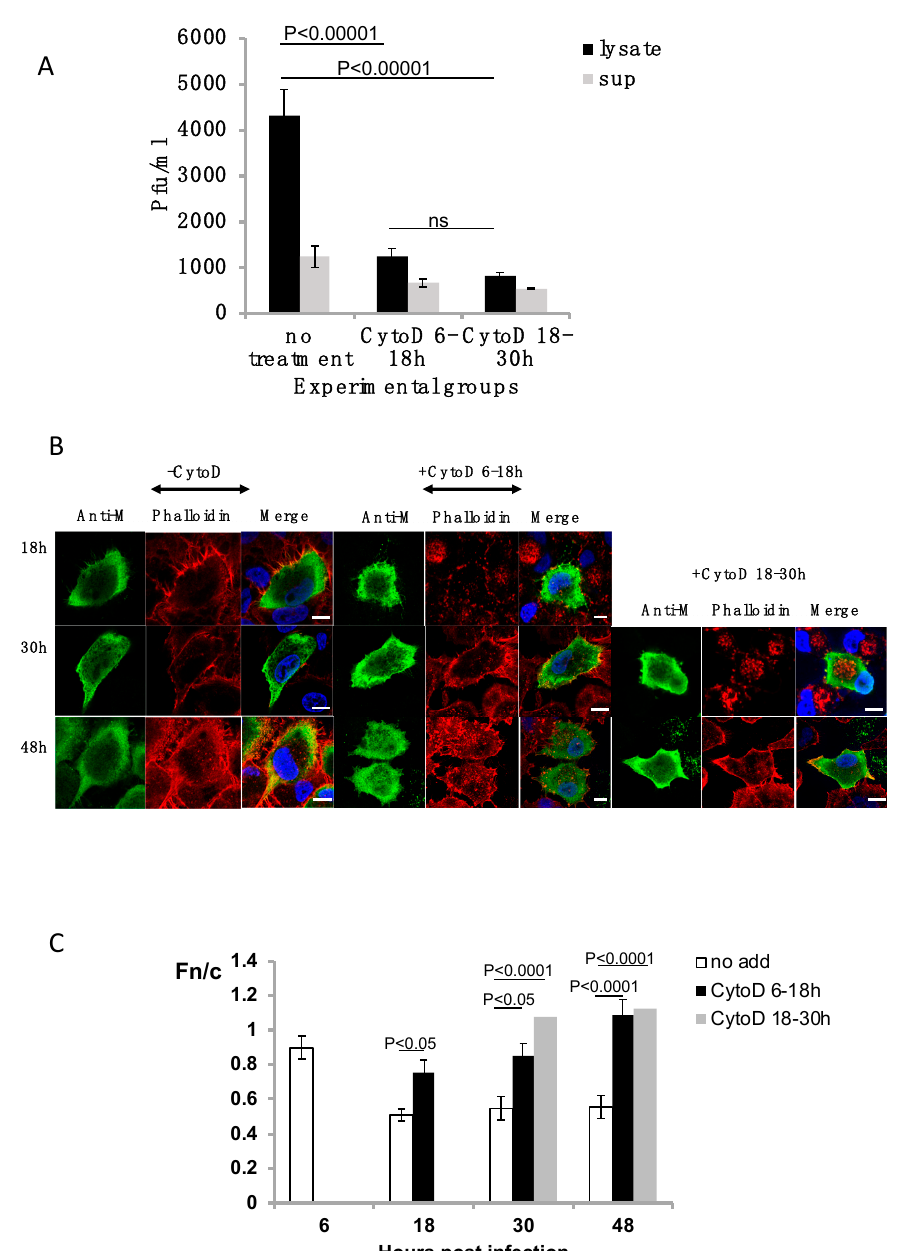
Figure 1. Treatment of respiratory syncytial virus (RSV)-infected A549 cells with cytochalasin D. Overnight cultures of A549 cells were infected with RSV A2 at MOI = 1. Cells were either left untreated (no treatment) or treated at early (6–18 h p.i.) or late (18–30 h p.i.) times in infection with cytochalasin D (CytoD). ( A ) A549 cells were infected with RSV (MOI = 1) and either left untreated or treated (experimental groups) with cytochalasin D early (6–18 h p.i.) or late (18–30 h p.i.) in infection. The cell lysates (lysate) and supernatants (sup) were collected at 48 h p.i., and infectious virus titer (pfu/mL) estimated by immunoplaque assay. ( B ) Infected cells were fixed at indicated times p.i. (numbers on the left) and probed for localization of M and microfilament network (phalloidin). Representative images are shown. Scale bars = 10 μ m. ( C ) Images such as those shown in ( B ) were analyzed using ImageJ to determine the relative fluorescence of nucleus to cytoplasm (Fn/c) as shown. Data are mean ± SEM, n ≥ 15 from an experiment representative of three independent experiments. Statistically significant differences between groups are shown, ns = non-significant. p values were determined by 2-way ANOVA and significance accepted at p < 0.05.